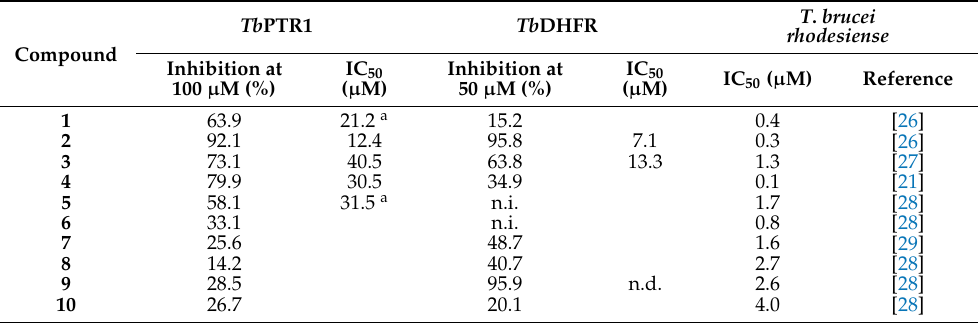
Table 1. Inhibitory activity of the sesquiterpene lactones tested in vitro against Tb PTR1 and Tb DHFR. The IC 50 values for in vitro growth inhibition of T . brucei rhodesiense as available in the literature are reported for comparison